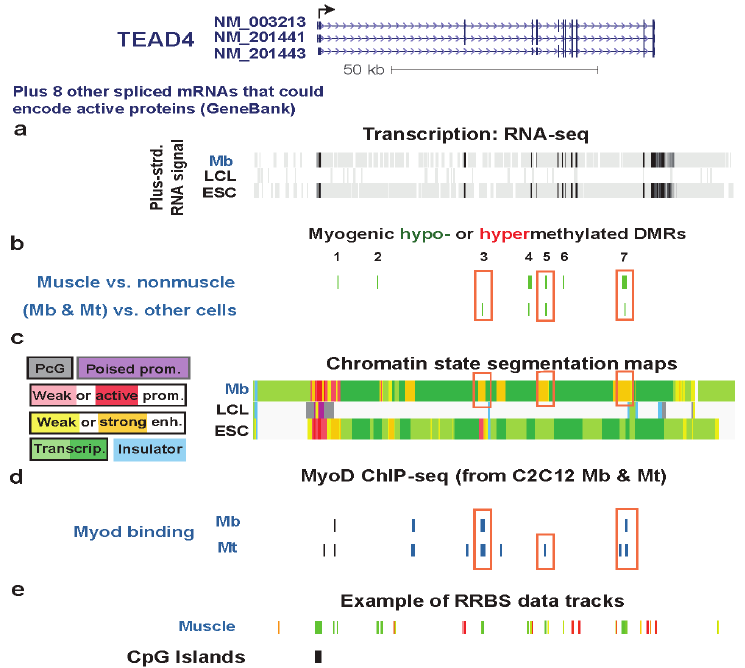
Figure 5. Multiple myogenic hypomethylated DMRs in the gene body of TEAD4